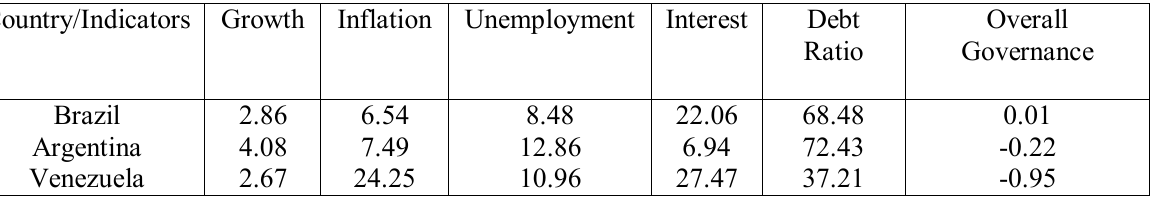
Table 1: Average values of key indicators of countries